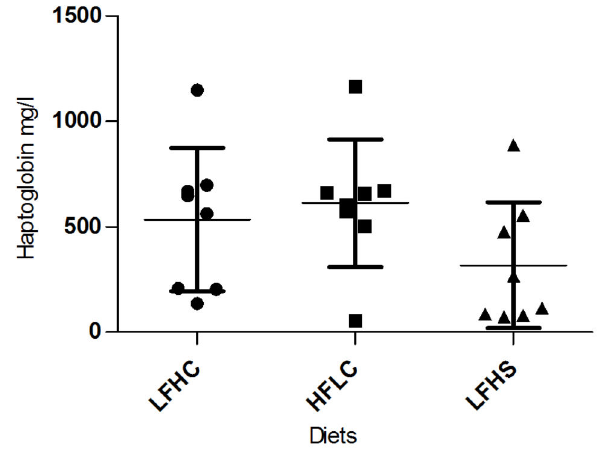
Figure 5. Haptoglobin in minipig serum by the end of the study. Haptoglobin concentrations (mg/l) ±SD for minipigs fed low fat, high carbohydrate diet (LFHC); high fat/cholesterol, low carbohydrate diet (HFLC); low fat, high carbohydrate/sucrose diet (LFHS).